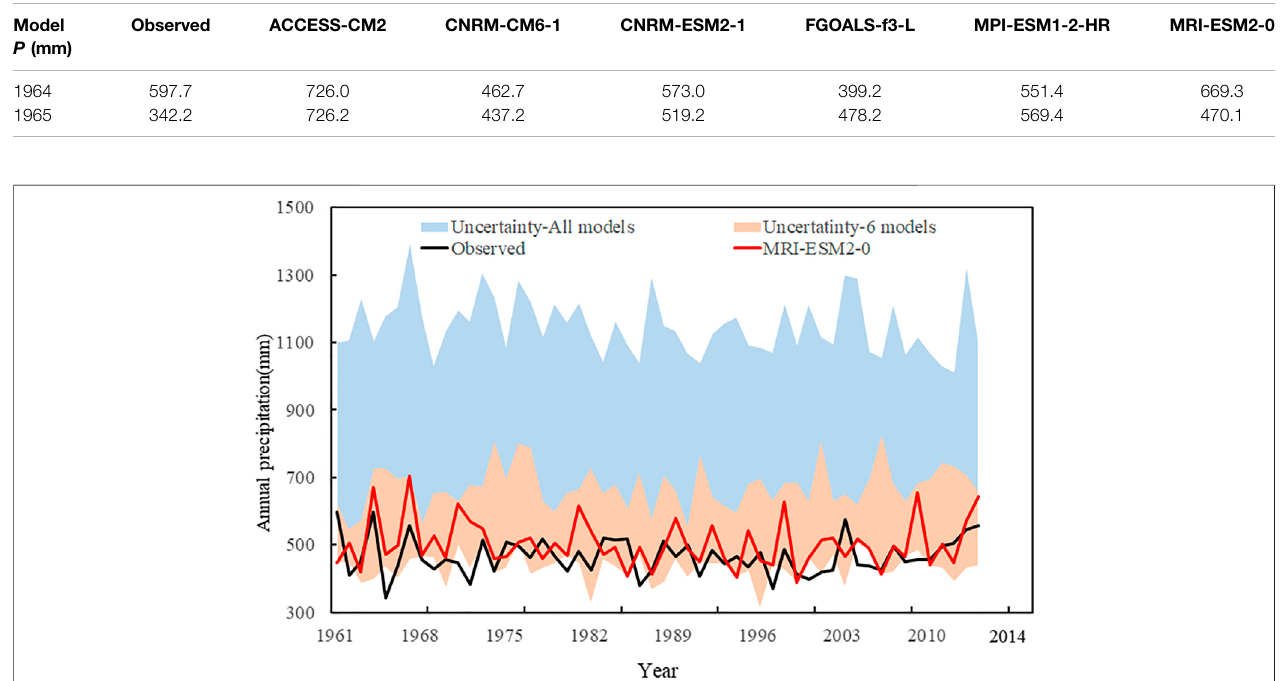
FIGURE 5 | Uncertainty interval of stimulated annual precipitation from the 19 GCMs and the six higher-scoring models. The black line is the annual precipitation change of the observed precipitation, and the red line is the annual precipitation change simulated by the GCM with the highest score.